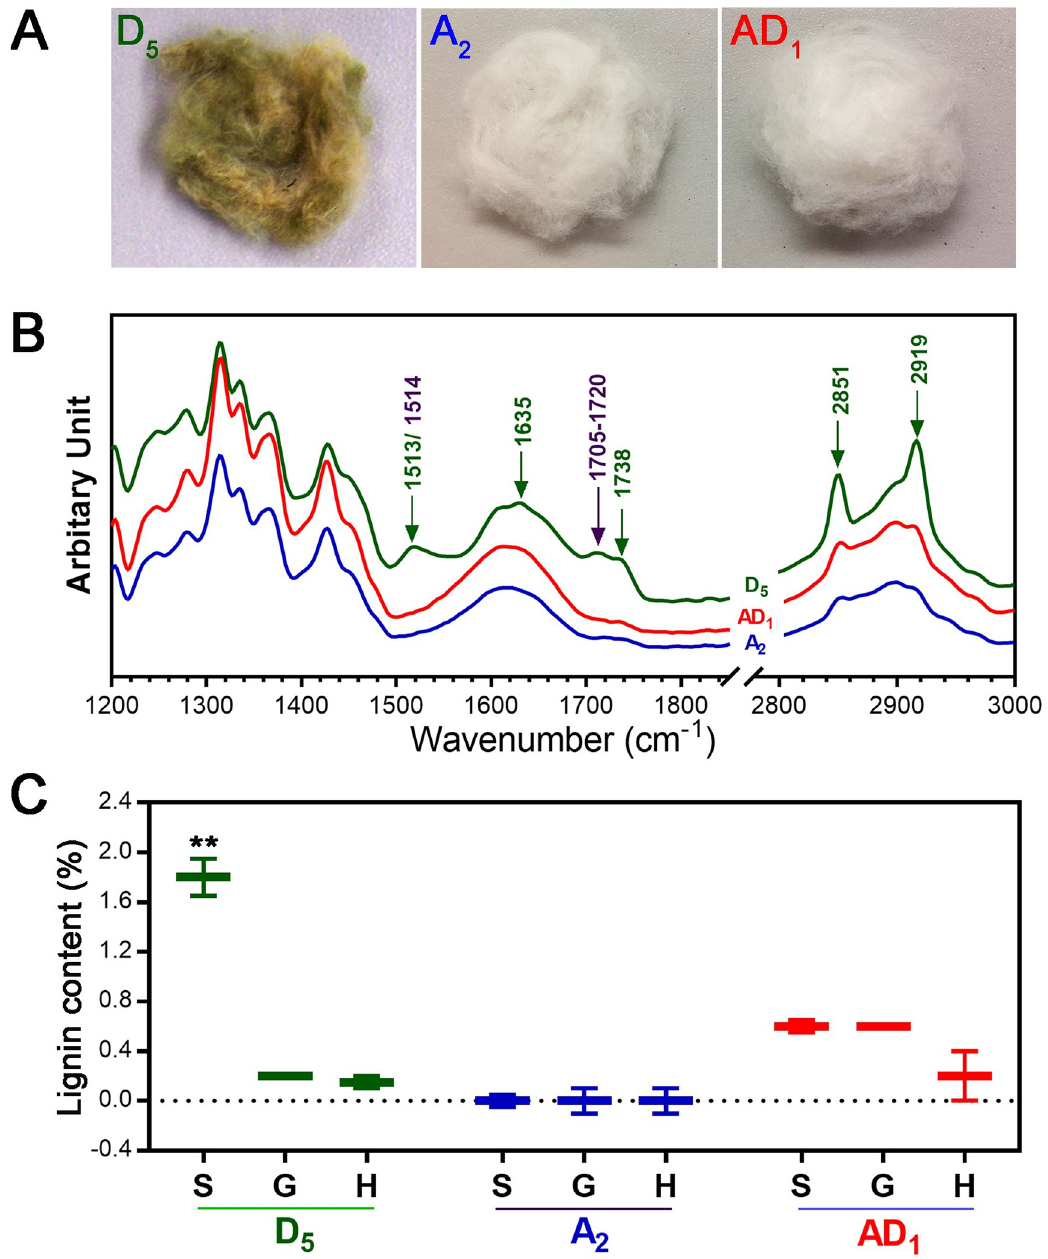
Fig 4. Suberin and lignin deposition in the wild diploid G . raimondii fibers among the 1 st set of cotton materials. A. Color differences of ginned and fully developed fibers from diploid G . raimondii D 5 -31 (D 5 ), diploid G . arboreum A 2 -100 (A 2 ), and polyploid G . hirsutum TM-1 (AD 1 ). B. ATR FT-IR spectra. Each spectrum of the three cotton species fibers was normalized and compared. The wavenumbers representing suberin and lignin were labeled green and purple, respectively. C. Lignin quantification. Contents of syringyl (S), guaiacyl (G), and hydroxyphenyl (H) lignin were determined with pyrolysis-molecular beam mass spectrometry and compared among the three cotton species fibers. The error bars represent standard deviation. �� p value <